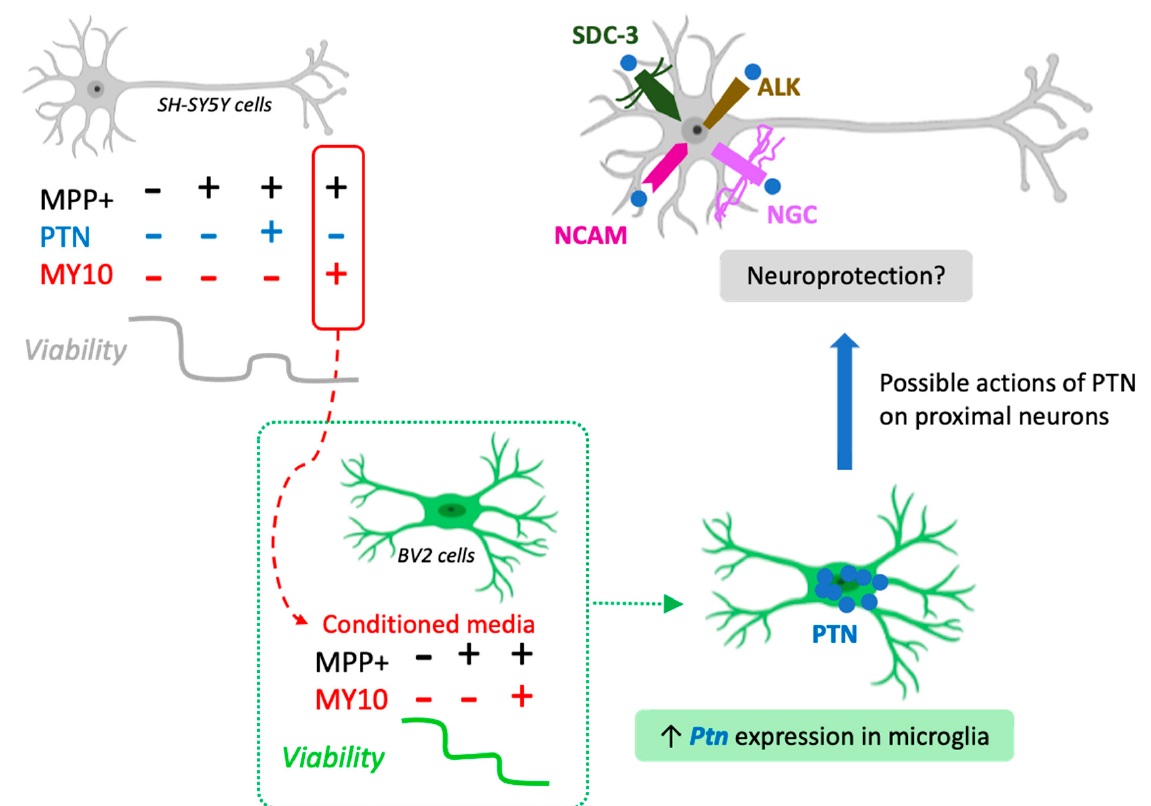
Figure 5. Microglial-induced neurotrophic response. Microglial injury caused by the treatment with conditioned media from SH-SY5Y cells treated with MPP+ is exacerbated when microglial cells are treated with the media from SH-SY5Y cells treated concomitantly with MY10 and MPP+. These treatments significantly induced the upregulation of Ptn mRNA in microglial cells. The data suggest a neuroprotective response of microglia through the increased secretion of microglial PTN and enhanced actions of this cytokine in proximal neurons expressing different PTN receptors. This figure was created with BioRender’s web-based software (https://biorender.com/ accessed 14 June 2021). SDC-3: Syndecan-3. ALK: Anaplastic lymphoma kinase. NCAM: Neural cell adhesion molecule. NGC: Neuroglycan C.